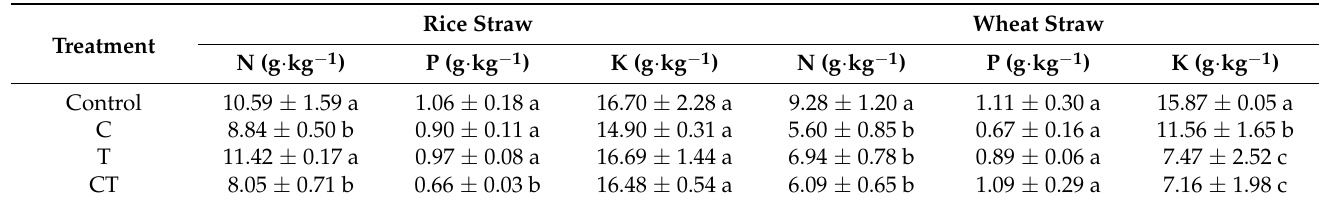
Table 2. Nutrients concentration of plant litter under elevated CO 2 and warming.